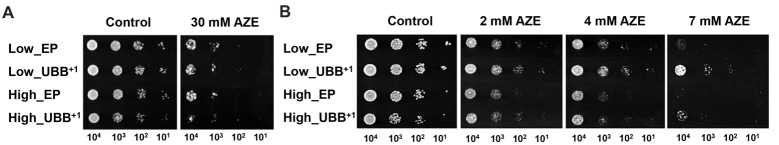
Low UBB+1 expression increases cellular tolerance to misfolded proteins. Spot tests to analyze the effect of chemically induced protein misfolding on survival of UBB+1 expressing strains and control strains. (A) Exponential cells, incubated for 3 h with 30 mM L-azetidine-2-carboxylic acid (AZE), were 10-fold serial diluted and spotted on selective plates. The control cultures were left untreated. (B) Exponential cells were spotted in 10-fold serial dilutions on plates containing 2 mM, 4 mM and 7 mM of AZE, respectively. Every sample was measured in duplicate on two independent transformants and in three independent experiments.